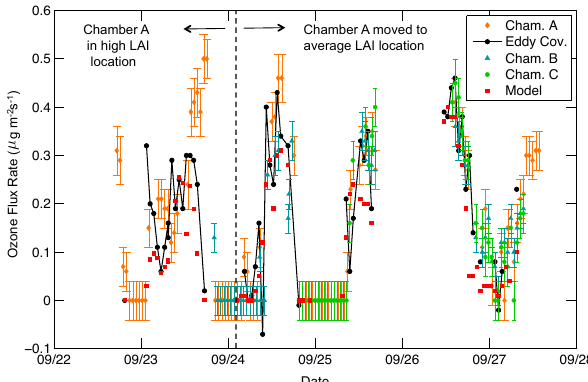
Figure 5. The plot above compares O 3 fluxes measured using eddy covariance (solid black line and black dots); surface-exchange mod- eling (red squares); and flux chambers A (orange diamonds), B (blue triangles), and C (green circles). The error bars represent the 95% confidence interval. The tick marks represent midnight on